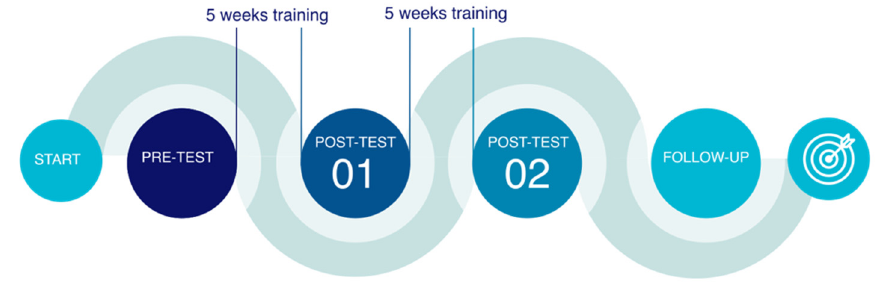
Figure 1. Phases of the study [23].